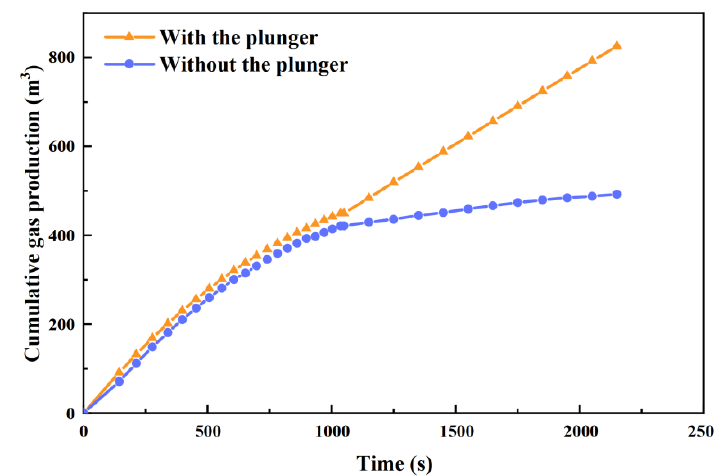
Figure 7. Variation in gas production.